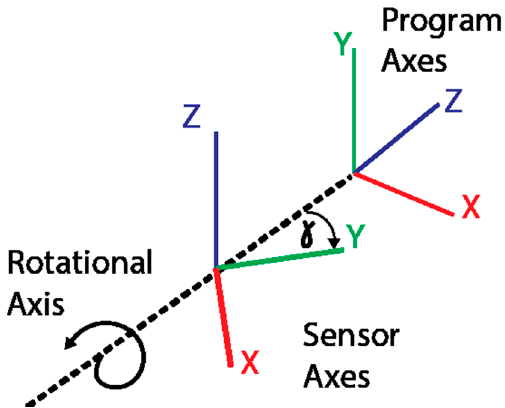
Figure 6. Different orientations of the rotation axis between the attention pose and the T-pose.